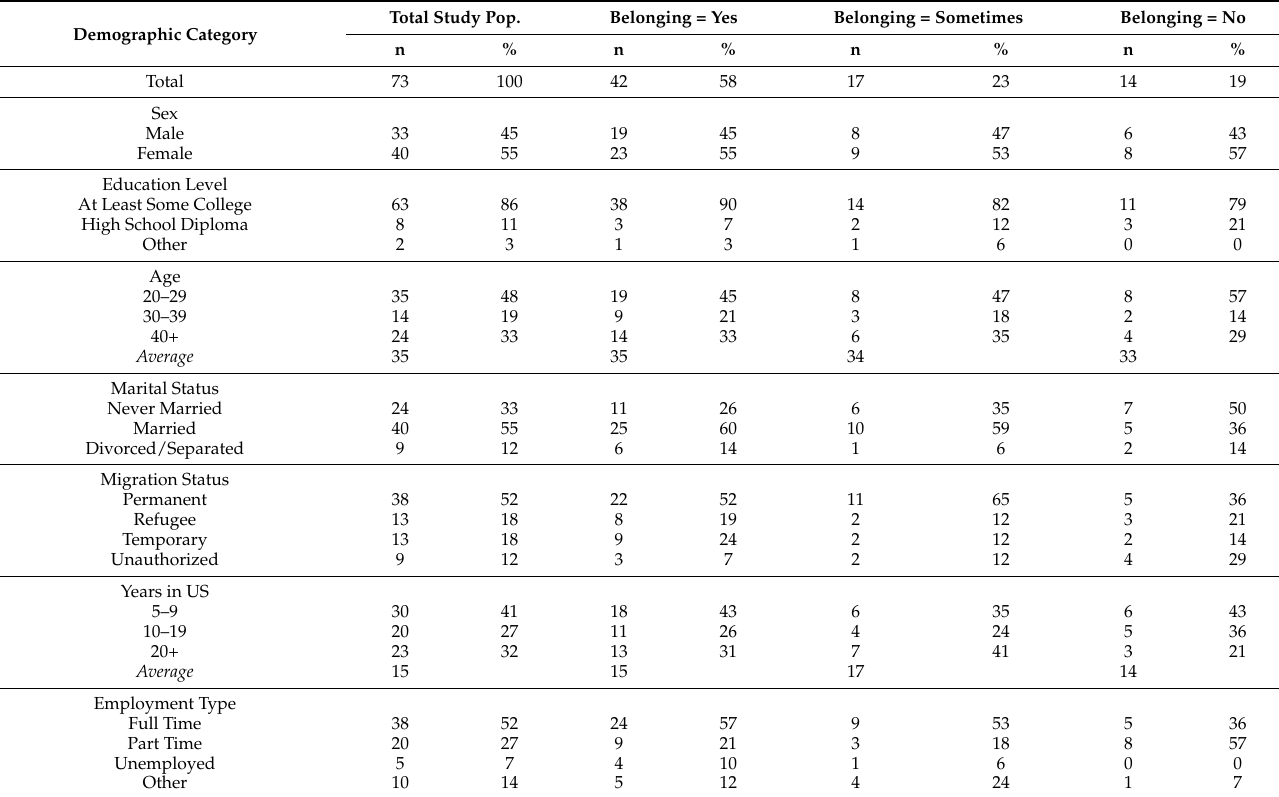
Table A1. Summary of Interviewee Demographic Information by Sense of